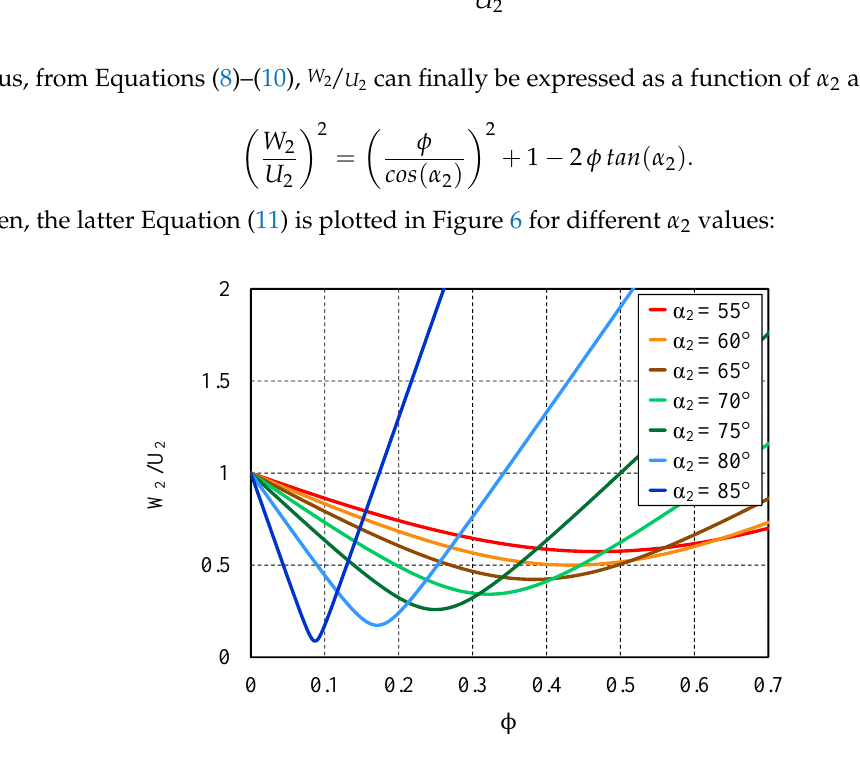
Figure 6. Evolution of W 2 / U 2 as a function of φ and α 2 (adapted from Chen and Baines